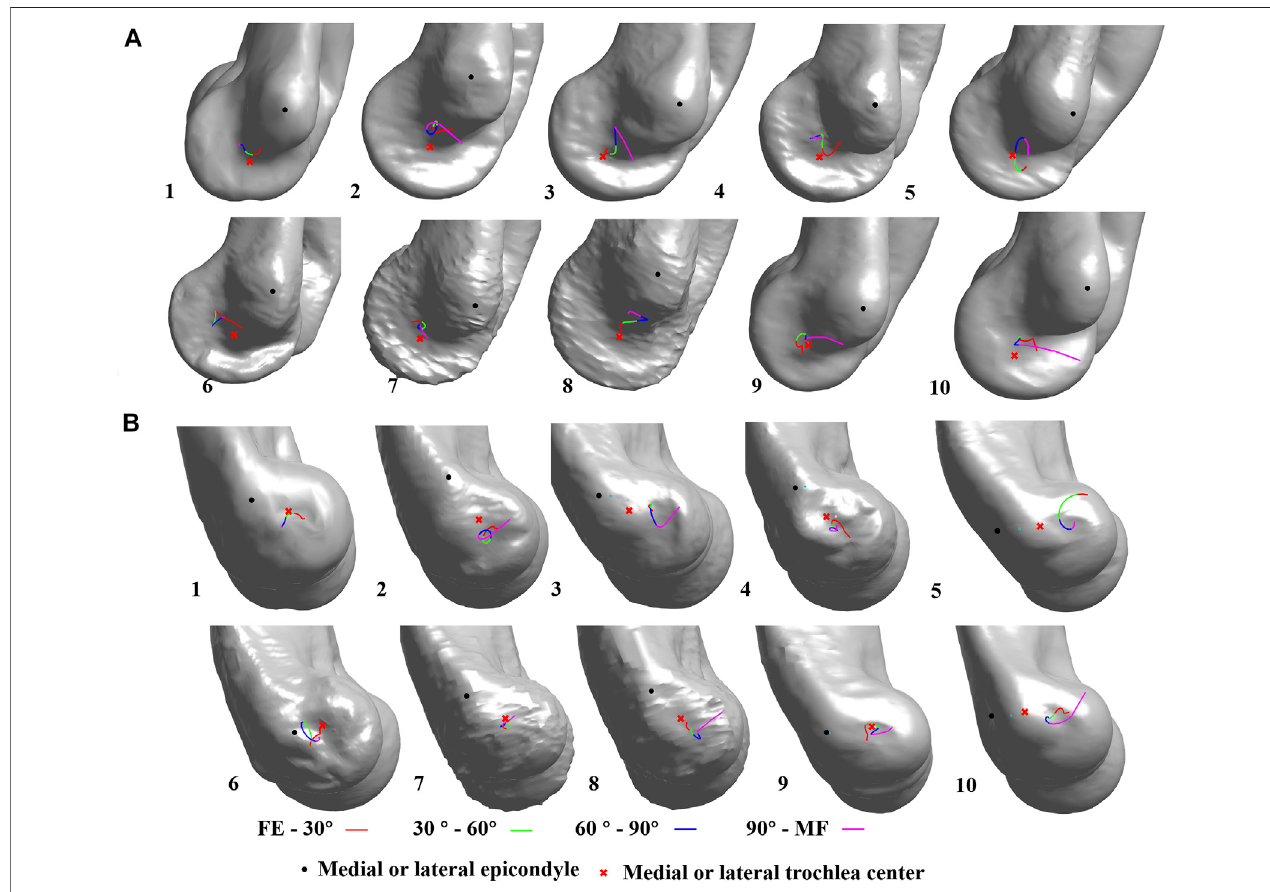
FIGURE 4 | Dynamic fl exion axis (DFA) change among all subjects. The continuous change in the DFA is represented by four colors which indicate four fl exion – extension phases. FE, full-extension; MF, maximum fl exion; (A) medial view; (B) lateral view.